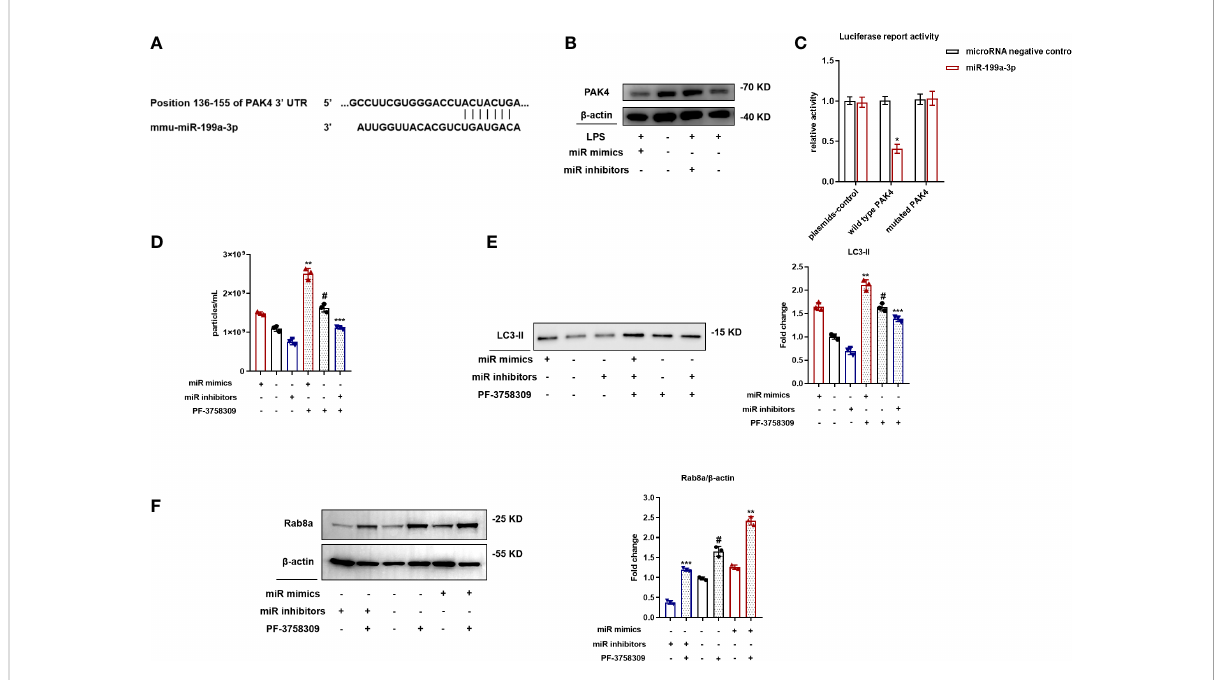
FIGURE 6 MiR-199a-3p mimics activate Rab8a by directly reducing PAK4 expression. (A) The predicted MiR-199a-3p binding site on the PAK4 3 ′ -UTRs was determined using target prediction software. (B) Western blot analysis validated the PAK4 expression when cells were transfected with the MiR-199a-3p mimic/inhibitor. (C) Luciferase reporter plasmid assays with wild-type and mutated PAK4 plasmids co-transfected with MiR-199a- 3p- or MiR-NC-packaged plasmids. Dual luciferase control vector plasmids acted as NCs. (D) Nanoparticle tracking analysis revealed signi fi cant increases in the level of vesicles from PF-3758309-stimulated RAW264.7 cells in the MiR-199a-3p mimic and inhibitor groups compared with the control group. (E) Western blot analysis demonstrated signi fi cant increases in LC3-II levels in vesicles from PF-3758309-stimulated RAW264.7 cells in the MiR-199a-3p mimic and inhibitor groups compared with the control group. (F) Western blot analysis revealed the effect of PF-3758309 on increasing Rab8a levels in RAW264.7 cells transfected with MiR-199a-3p mimics and inhibitors. The experiments were repeated at least three times (n = 3 per group). Each value represents the mean ± SD of three independent experiments. *p < 0.05 vs . the plasmid-control group transfected with MiR-199a-3p plasmids; #p < 0.05 vs . the control group; **p < 0.05 vs . the mimics group without PF- 3758309; ***p < 0.05 vs . the inhibitors group without PF-3758309, one-way